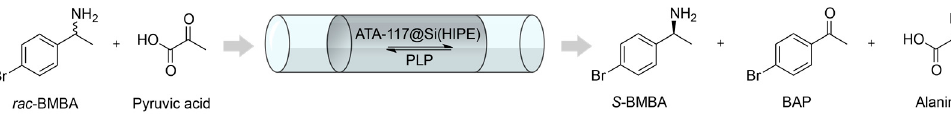
Figure 5. Flow kinetic resolution of rac -BMBA by ATA-117 transaminases immobilized on Si(HIPE) monolith. As ATA-117 is R- selective, it only accepts the R- BMBA as a substrate, leaving the S- BMBA unreacted. PLP stands for Pyridoxal phosphate, the transaminase cofactor.